Question: Provide a one-line summary of what is displayed.
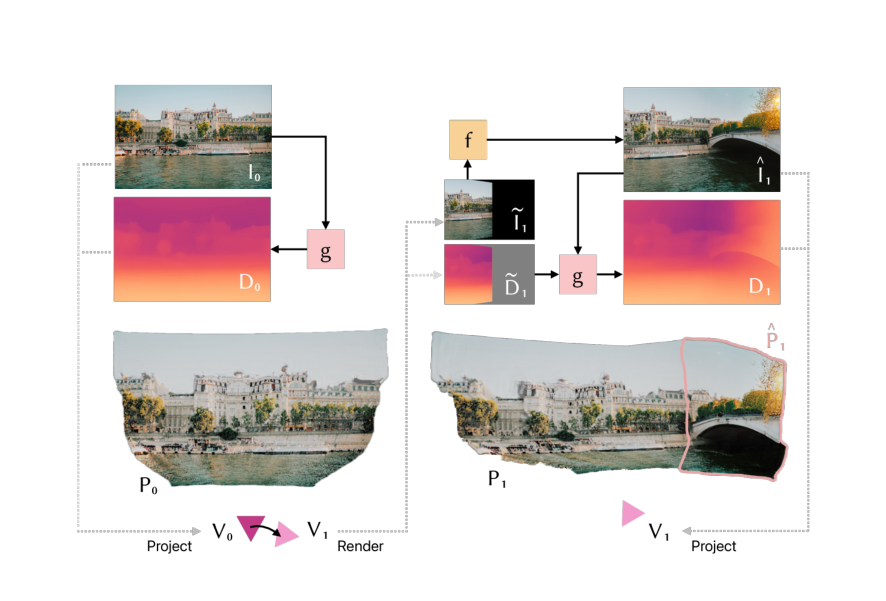
Answer: Overview of our 3D scene generation method. Starting from an input image I0, we project it to a point cloud based on a depth map predicted by a depth estimation network g. To extend the scene, we render it from a new view point and query a generative model f to hallucinate beyond the scene’s boundary. Now, we con- dition g on the depth of the existing scene and the image of the scene extended by f to produce a geometrically consistent depth map to project the hallucinated points. This process may be repeated until a 360-degree scene has been generated.